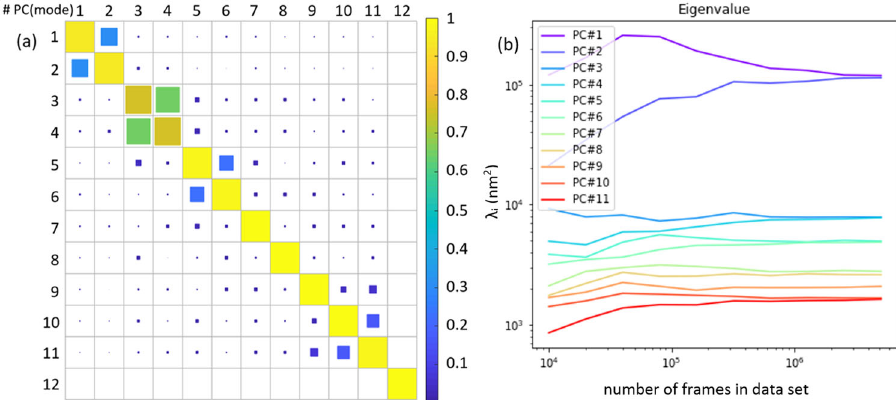
Fig. 5 Convergence test of the PCs. a The norm of the inner product between right singular vectors from PCA performed on a 2-million-frame (rows) and a 5-million-frame (columns) trajectory. b The eigenvalues λ i of the PCs i = 1 – 11 plotted against the number of frames in the analyzed data